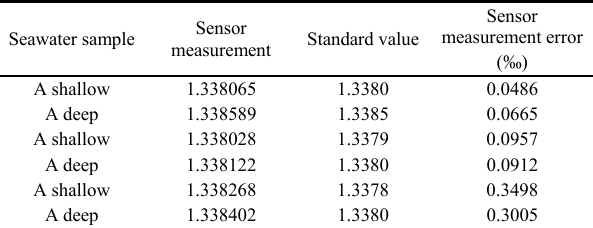
Table 3 Error analysis of measurement value and standard value of different seawater samples.